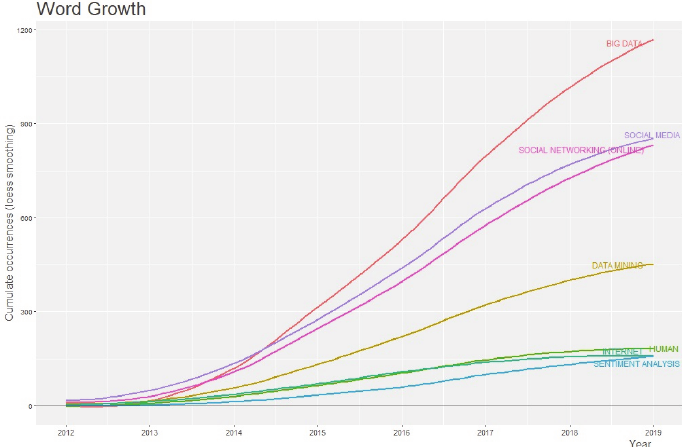
Fig. 4. Keywords plus dynamic view over time